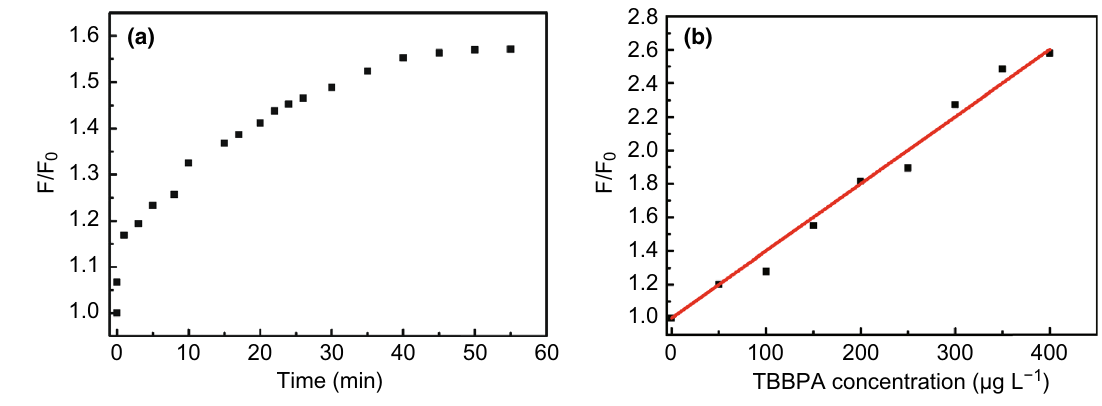
Fig. 18 a Photoluminescence enhancement ratio of MOF-74(Zn)-en in the presence of TBBPA (150 μg L −1 ) at different incubation time. b Calibration curves of photoluminescence enhancement ratios of MOF-74(Zn)-en in the presence of different concentrations of TBBPA (0–400 μg L −1 ). Reproduced with permission from Ref. [53]. Copyright 2019, Elsevier